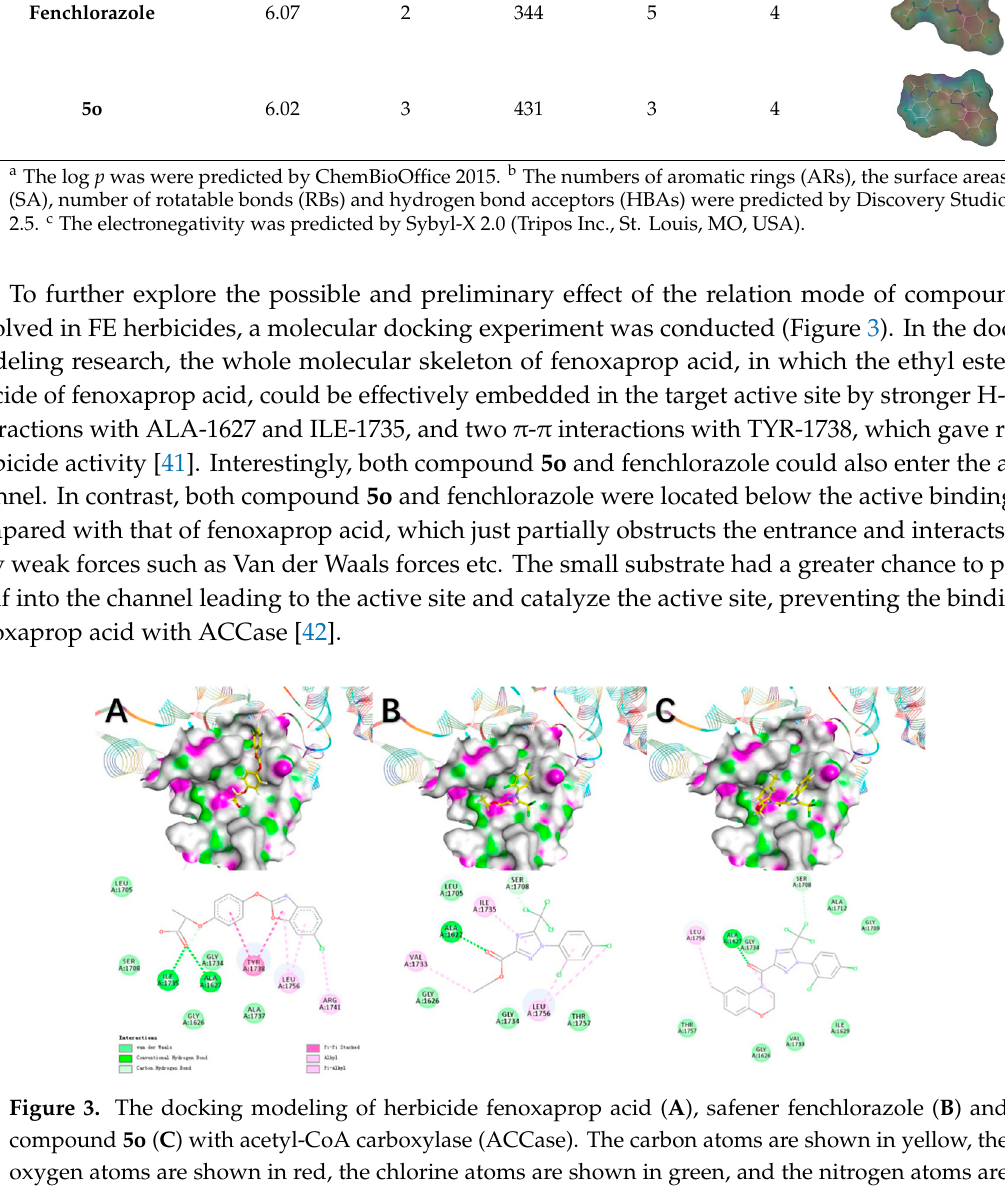
shown in light shown in light purple.